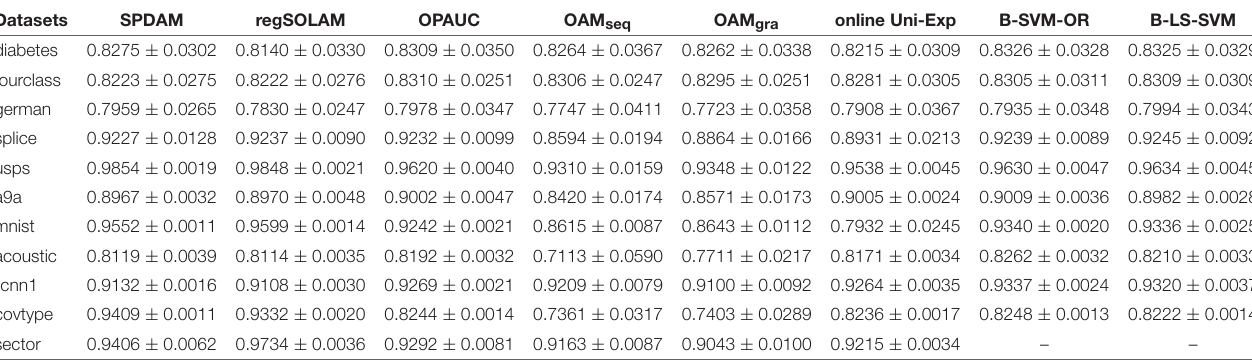
TABLE 3 | Comparison of the testing AUC values (mean